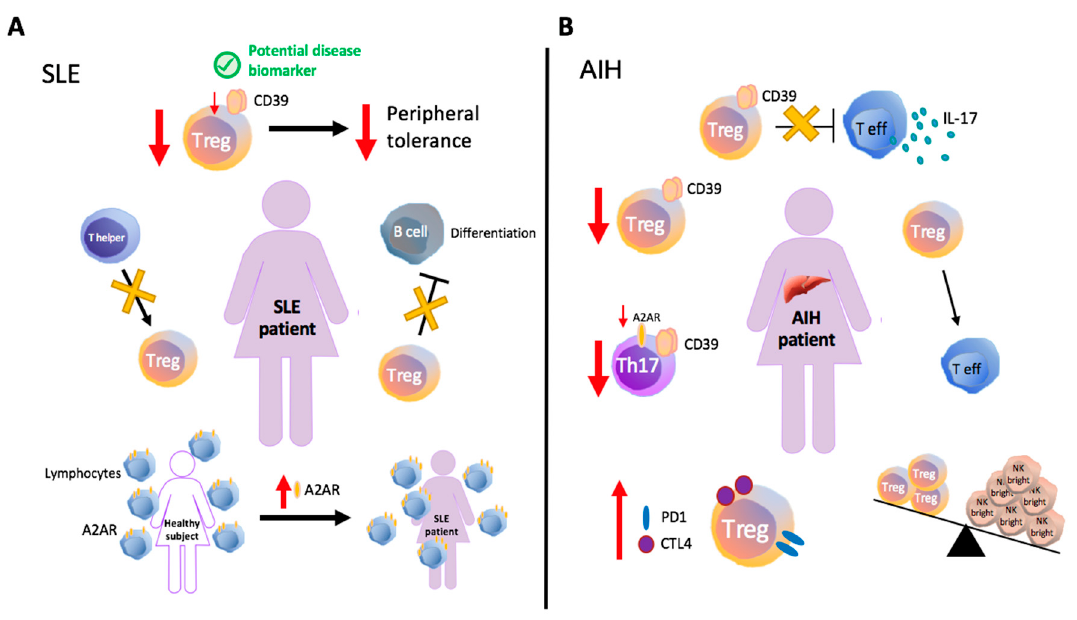
Figure 1. Immune and purinergic dysregulation in systemic lupus erythematosus (SLE) and autoimmune hepatitis (AIH). ( A ) In SLE, defects in ENTPD1/CD39 expression and impaired Treg function have been associated with loss of peripheral tolerance. Studies conducted in active SLE patients have indicated impaired suppression of B-cell differentiation and identified the abnormal generation of regulatory T-cells (Treg) as result of limited transition from inducer/helper to suppressor phenotype. Upregulation of A2AR is detectable in SLE patients, likely being linked to activation of compensatory pathways. ( B ) In type 1 autoimmune hepatitis (AIH-1), CD39 + Treg cells display impaired suppression of IL-17 production by CD4 + effectors. Acute AIH patients present a low ratio between Tregs and NK bright cells, a specific NK subset with activated effector phenotype. Activated memory phenotype and signs of exhaustion, including increased CTLA-4 and PD-1 levels are also typical of AIH Tregs. Reduced CD39 + Treg and CD39 + Th17-cell frequencies positively correlate with the disease progression and might result from cell instability upon pro-inflammatory challenge, with increased rate of conversion into effector lymphocytes. The reduction in CD39 + Th17-cell numbers, also associates with lower A2AR expression (see text below).